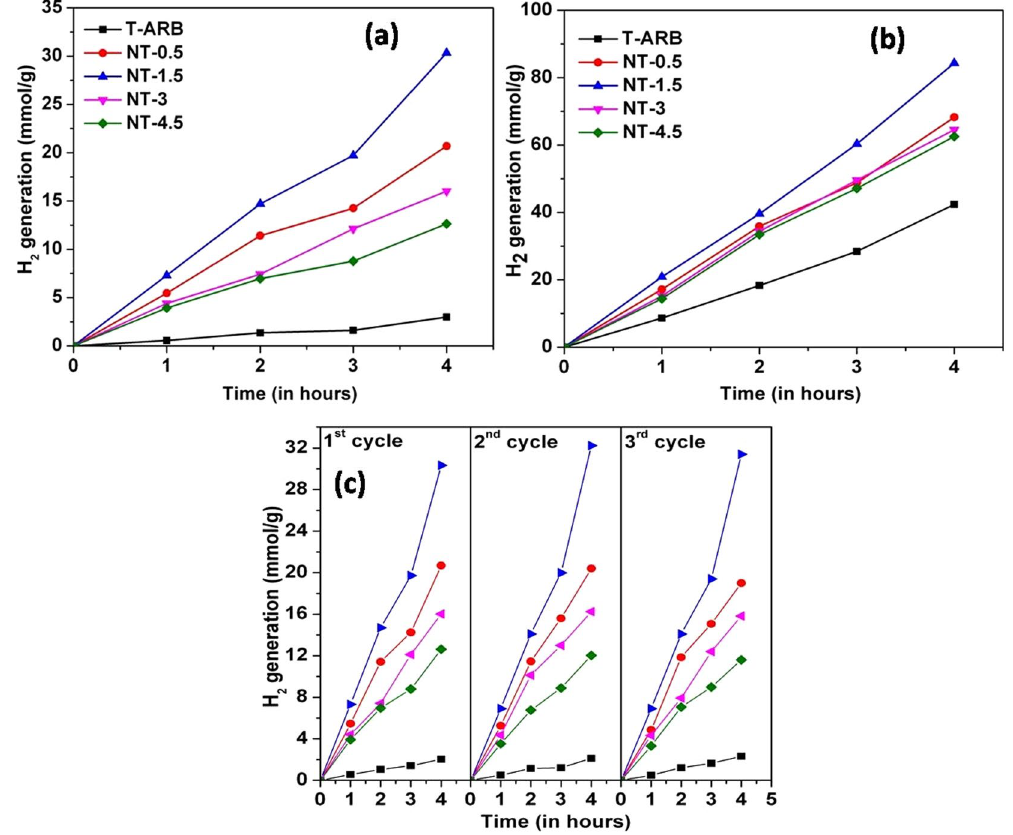
Figure 6. Hydrogen generation by ( a ) pristine T-ARB and N-TiO 2 nanotubes; ( b ) Pt loaded T-ARB and N-TiO 2 nanotubes, and ( c ) verification of stability of photocatalysts under one sun